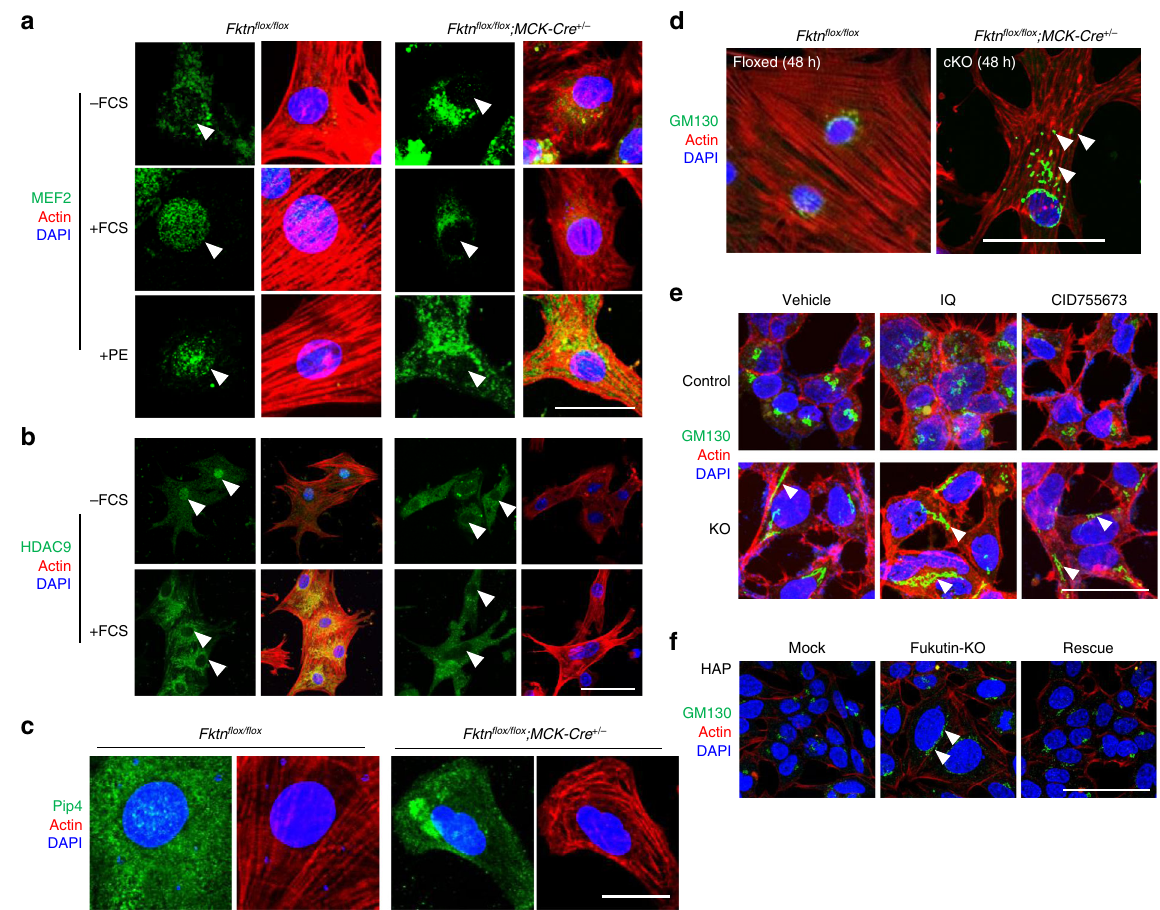
Fig. 5 Impaired MEF2-HDAC axis of MCK- Fktn -cKO ( Fktn fl ox/ fl ox ; MCK-Cre + / − ) cardiomyocytes. a Representative images of MEF2 localization in cardiomyocytes treated with FCS or PE for 48 h. Scale bar, 20 μ m. b Representative images of HDAC9 localization in cardiomyocytes cultured with or without FCS. Scale bar, 100 μ m. c Representative images of PI4P accumulation in cardiomyocytes. Scale bar, 20 μ m. d Representative images of GM130 distribution in cardiomyocytes. Scale bar, 50 μ m. e Effects of a PKD activator (ilimaquinone (IQ)) and a PKD inhibitor (CID755673) on GM130 distribution in control and FKTN -de fi cient (KO) HEK cells. Arrowheads show abnormally distributed GM130 signals. Scale bar, 100 μ m. f Representative images of GM130 distribution in control (mock), FKTN -de fi cient (fukutin-KO), and rescued (fukutin-KO transfected with pcDNA-FKTN-FLAG) HAP cells. Arrowheads show abnormally distributed GM130 signals. Scale bar, 100 μ